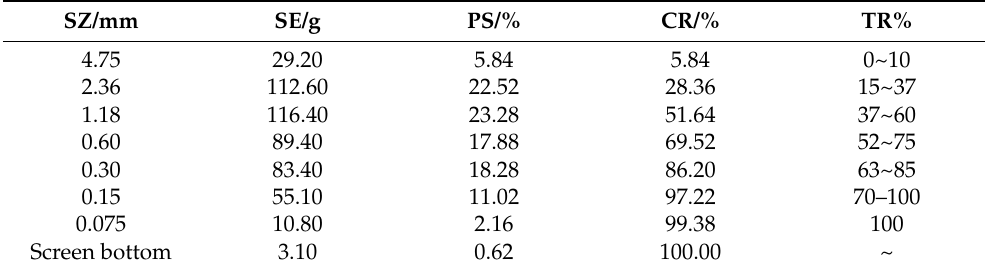
Table 1. Granulometry test for fine aggregate.